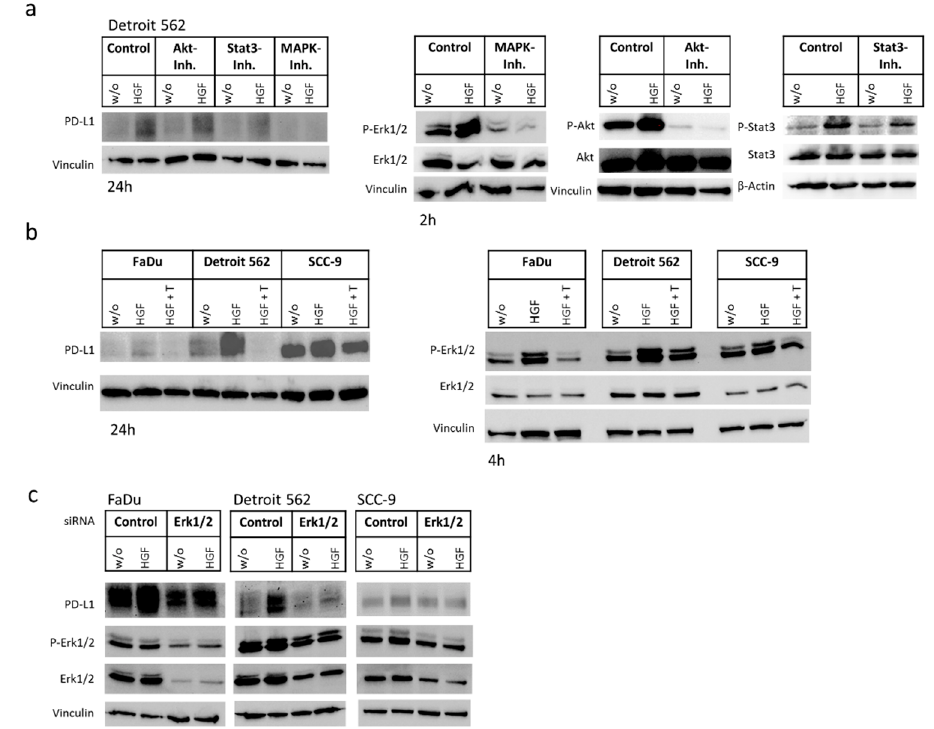
Figure 4. Increase in PD-L1 concentration is MAP kinase-dependent. ( a ) Lysates of Detroit 562 cells treated with 50 ng / mL HGF and / or the indicated inhibitors (Akt-Inh.: 1 µ M MK-2206, Stat3-Inh.: 100 µ M S3I-201, MAPK-Inh.: 1 µ M SCH772984) for 24 h or corresponding untreated controls ( w / o ) were subjected to Western blotting using a PD-L1 specific antibody (on the left). To show the e ff ect of HGF on the pathways and to check for the e ff ectiveness of the inhibitors, samples were made after 2 h incubation as well, and a Western blot was performed with indicated antibodies (on the right). ( b ) Indicated cell lines were incubated for 24 h (on the left) or 4 h (on the right, to show the e ff ect of HGF and Trametinib on pathway activation) with 50 ng / mL HGF alone or in combination with trametinib (T) or were left untreated ( w / o ). E ff ect on PD-L1 protein (on the left) and phosphorylated Erk1 / 2 protein (on the right) was investigated in a Western blot. Untreated samples served as controls ( w / o ). ( c ) Cells were transfected with Erk1 / 2 specific siRNA or a control siRNA. Two days later, cells were treated with 50 ng / mL HGF or remained untreated ( w / o ). After two more days, lysed cells were subjected to Western blotting using the indicated antibodies. Vinculin and β -actin were detected to check for equal gel loading. Typical results out of at least three experiments are